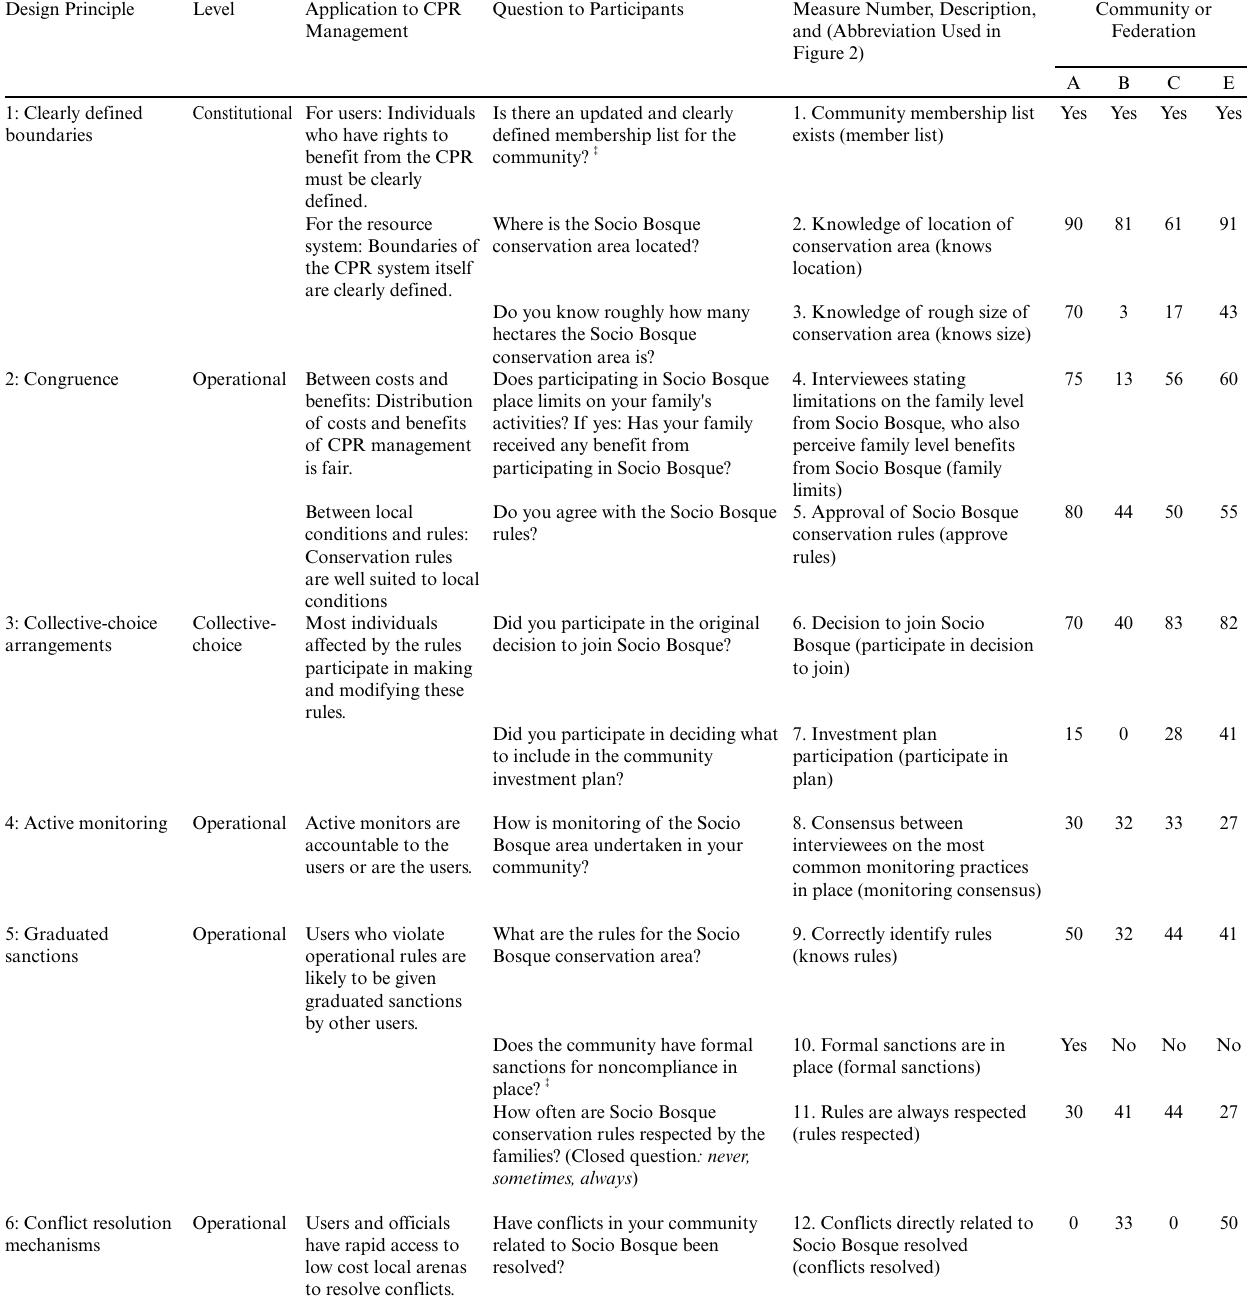
Table 2 . The 6 design principles for sustainable common pool resource management from Ostrom (1990) assessed by 94 structured interviews in 4 indigenous communities in Ecuador (n = 20 in community A, 34 in federation B, 18 in community C, and 22 in community E). †